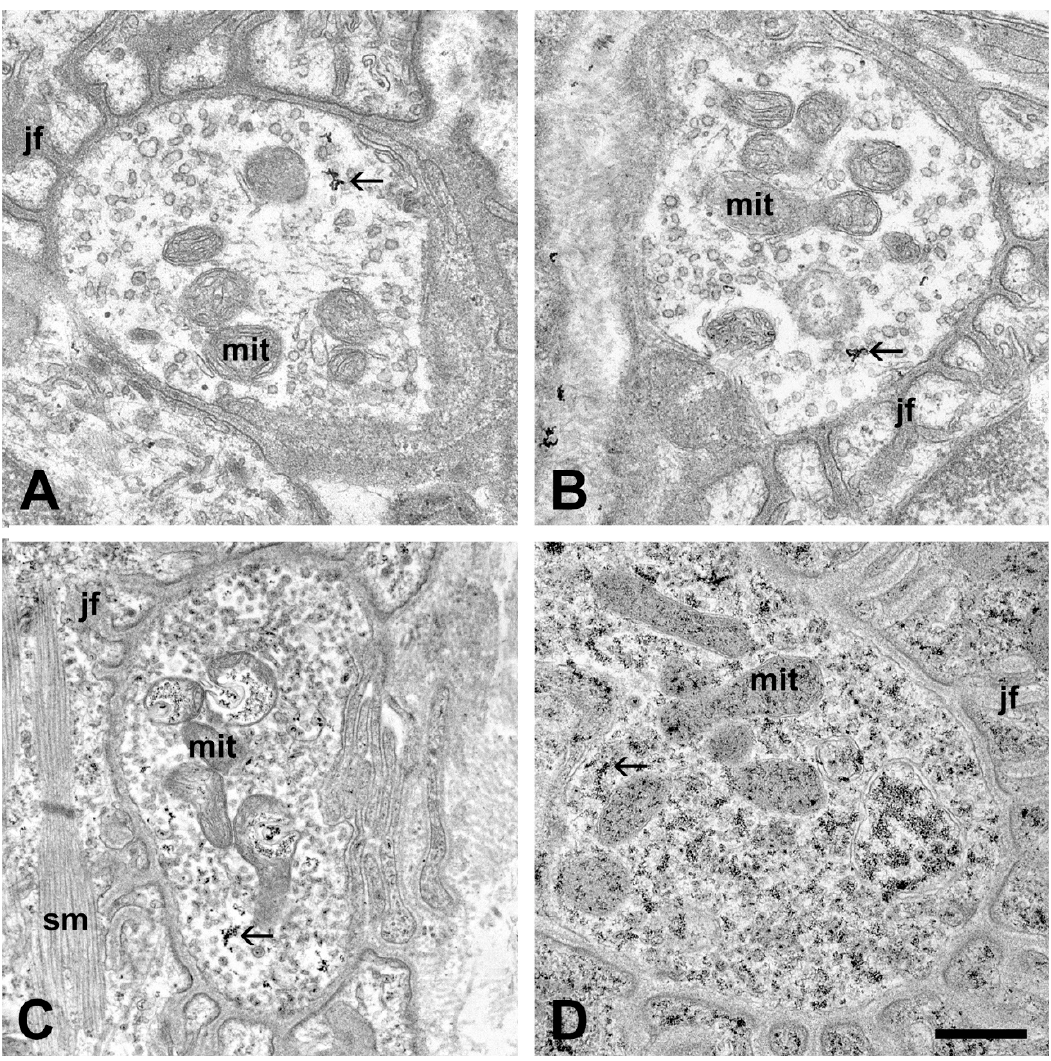
Figure 2. Electron micrographs of the neuromuscular synapses in the interosseous muscles after oxalate-pyroantimonate fixation. Junctional folds (jf) with no structural alterations are visible around all axon terminals. Axon terminals from an untreated mouse ( A ), and from a mouse injected with serum from a healthy individual ( B ) show no sign of structural damage, and contain intact mitochondria (mit). Furthermore, calcium-containing electron-dense deposits (EDDs) are only sparsely visible (arrows). Axon terminals from mice injected with sera from ALS patients, exemplified with superoxide dismutase 1 (SOD1) pAsp90Ala ( C ) and chromosome 9 open reading frame 72 (C9ORF72 ( D )) mutations, display an increased amount of EDDs (arrows), particularly in ( D ). Furthermore, a global increase in synaptic vesicles can be noted. Occasionally, swollen mitochondria (mit) with clusters of EDDs are visible ( C ). sm: skeletal muscle. Scale bar: 500 nm.